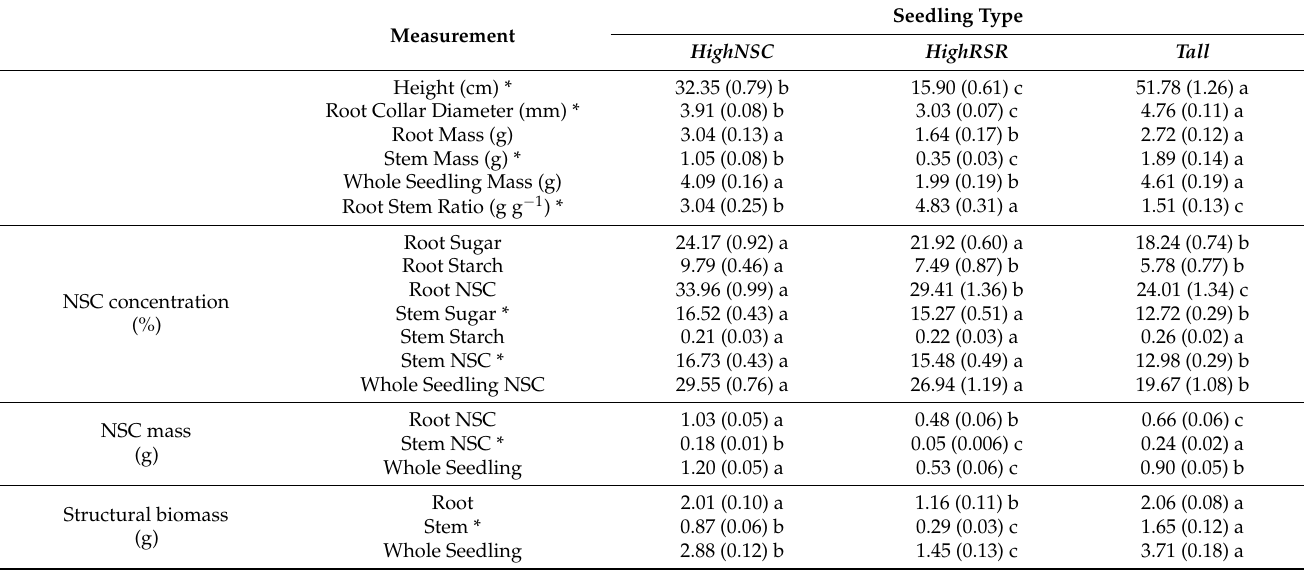
Table A1. Summary of initial measurement means ( ± SE) for aspen by seedling type. Different letters indicate significant differences among seedling types using Tukey-HSD post hoc tests ( p ≤ 0.10, n = 15).